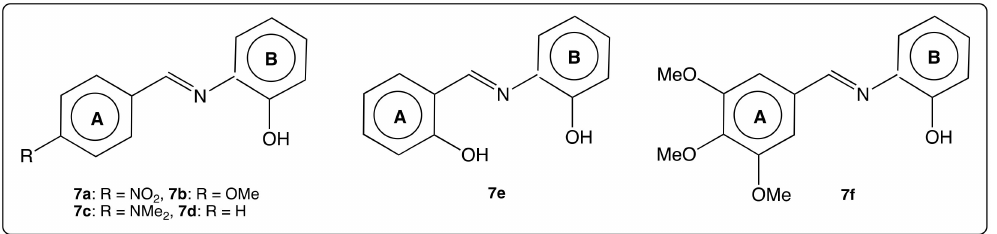
Figure 9. Structure of AZA-ST 7a – f [62].